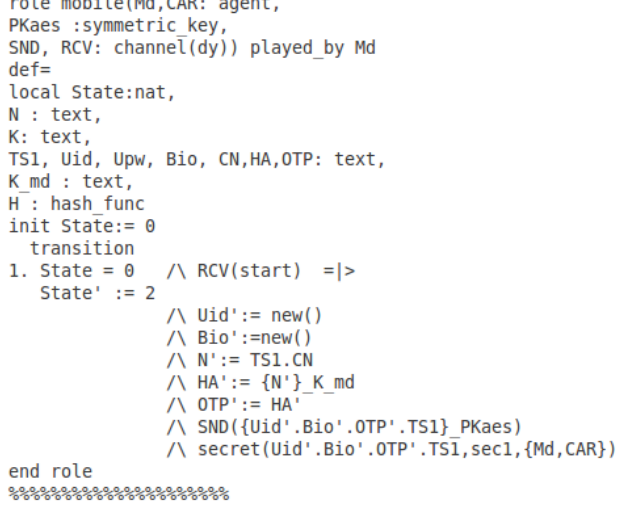
Figure 18. The mobile device’s role in HLPSL.